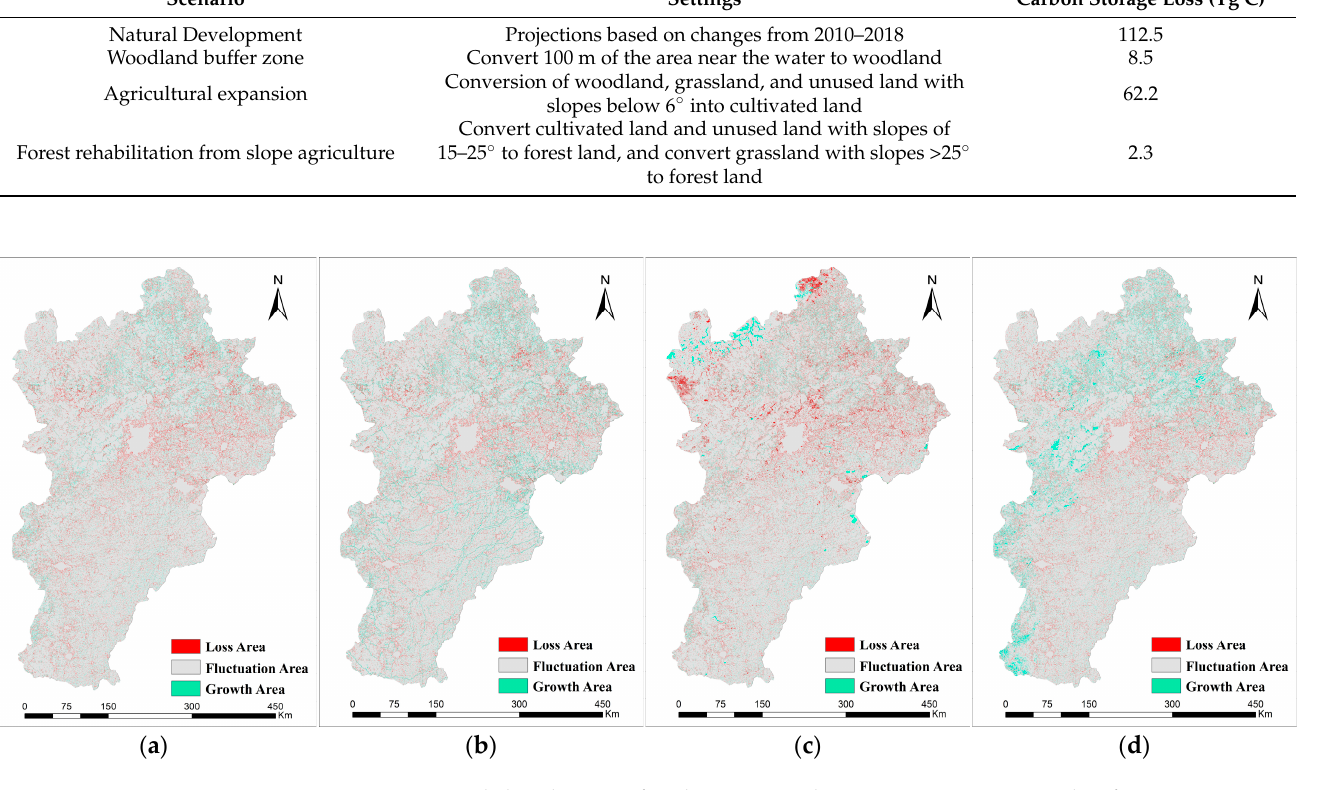
Figure 9. Spatial distribution of carbon storage loss in Beijing-Tianjin-Hebei from 2018 to 2030. ( a ): Natural Development scenario, ( b ): Woodland buffer zone scenario, ( c ): Agricultural expansion sce- nario, ( d ): Forest rehabilitation from slope agriculture scenario. Table 7. Specific settings of scenario simulations with corresponding carbon storage loss.